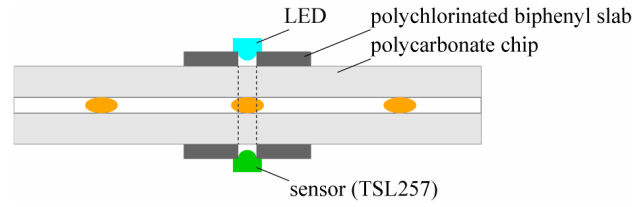
Figure 1. Scheme of the integrated detector.